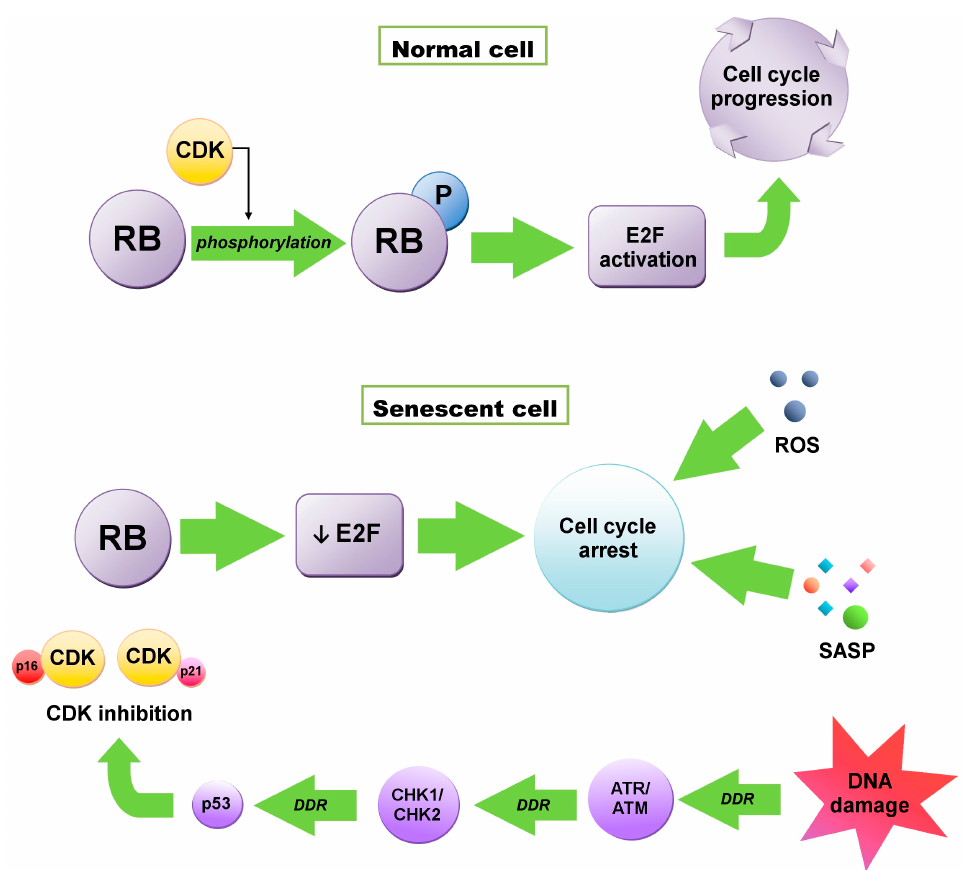
Figure 1. Retinoblastoma (RB)-dependent cell cycle arrest. In normal cells RB is phosphorylated by cyclin-dependent kinases (CDKs). Enhancement of E2F transcription factor activity occurs, which is required for cell cycle progression. In senescent cells, CDKs are inhibited by P16 or P21, which can be activated as a result of DNA damage response (DDR) through ataxia telangiectasia and Rad3-related kinase (ATR)/ataxia telangiectasia mutated kinase (ATM) → checkpoint kinase 1 /checkpoint kinase 2 (CKH1/CHK2) → P53 pathway. E2F repression occurs, which leads to the cell cycle arrest maintained by the senescence-associated secretory phenotype (SASP) and reactive oxygen species (ROS).